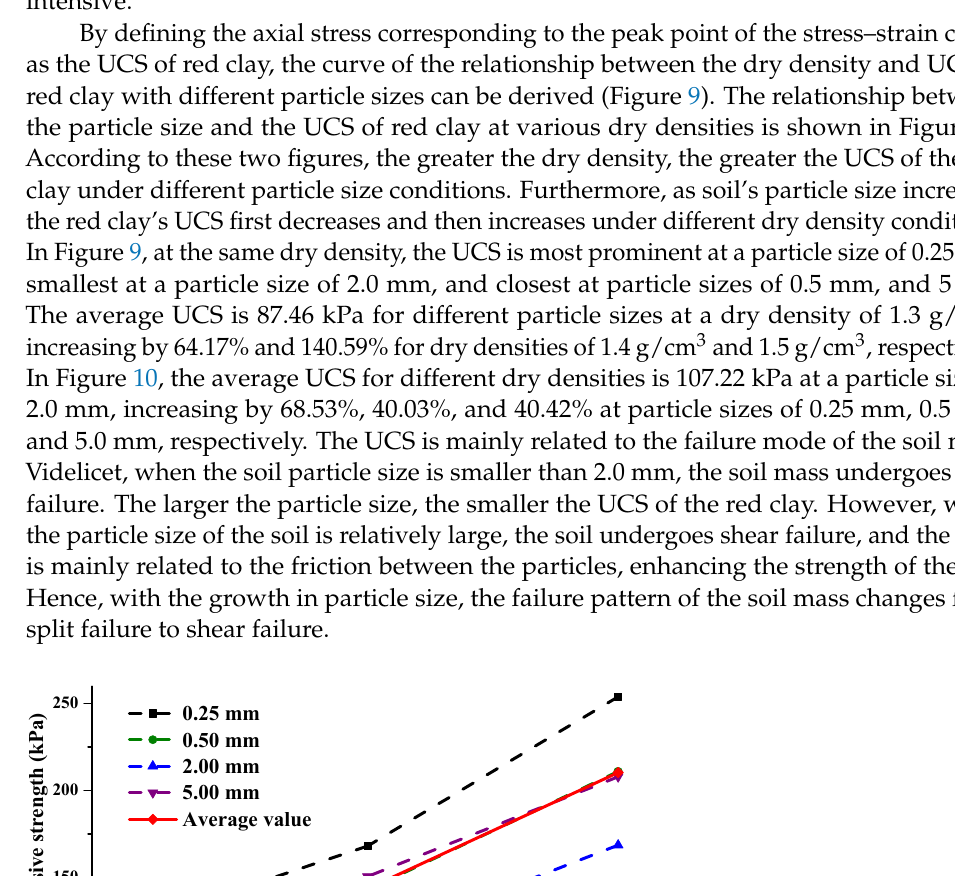
Figure 10. The fitting curve of particle size and UCS at different dry densities. 3.3. Results of Macro Cracks 3.3.1. The Influence of WD Cycles on the Crack of Red Clay with Different Particle Sizes Red clay samples with different particle sizes and dry densities were subjected to 12 WD cycle tests, and three-dimensional crack extraction was performed on a ring knife sample of each. The fracture extraction process of the twelfth cycle of the soil sample with a dry density of 1.3 g/cm 3 and particle size of 0.25 mm is illustrated in Figure 11. ( a ) ( b ) ( c ) Figure 11. Fracture extraction process: ( a ) original image; ( b ) crack filling; ( c ) crack extraction.